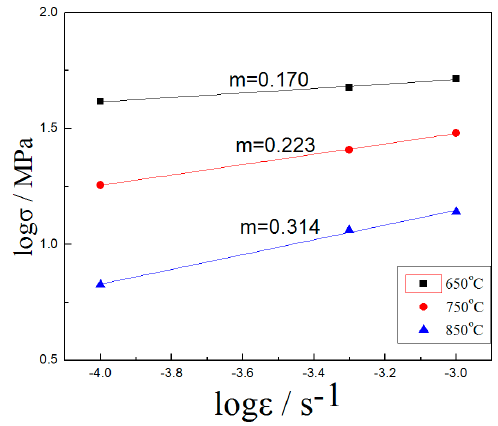
Figure 4. m Value of high temperature tensile of H13 steel.